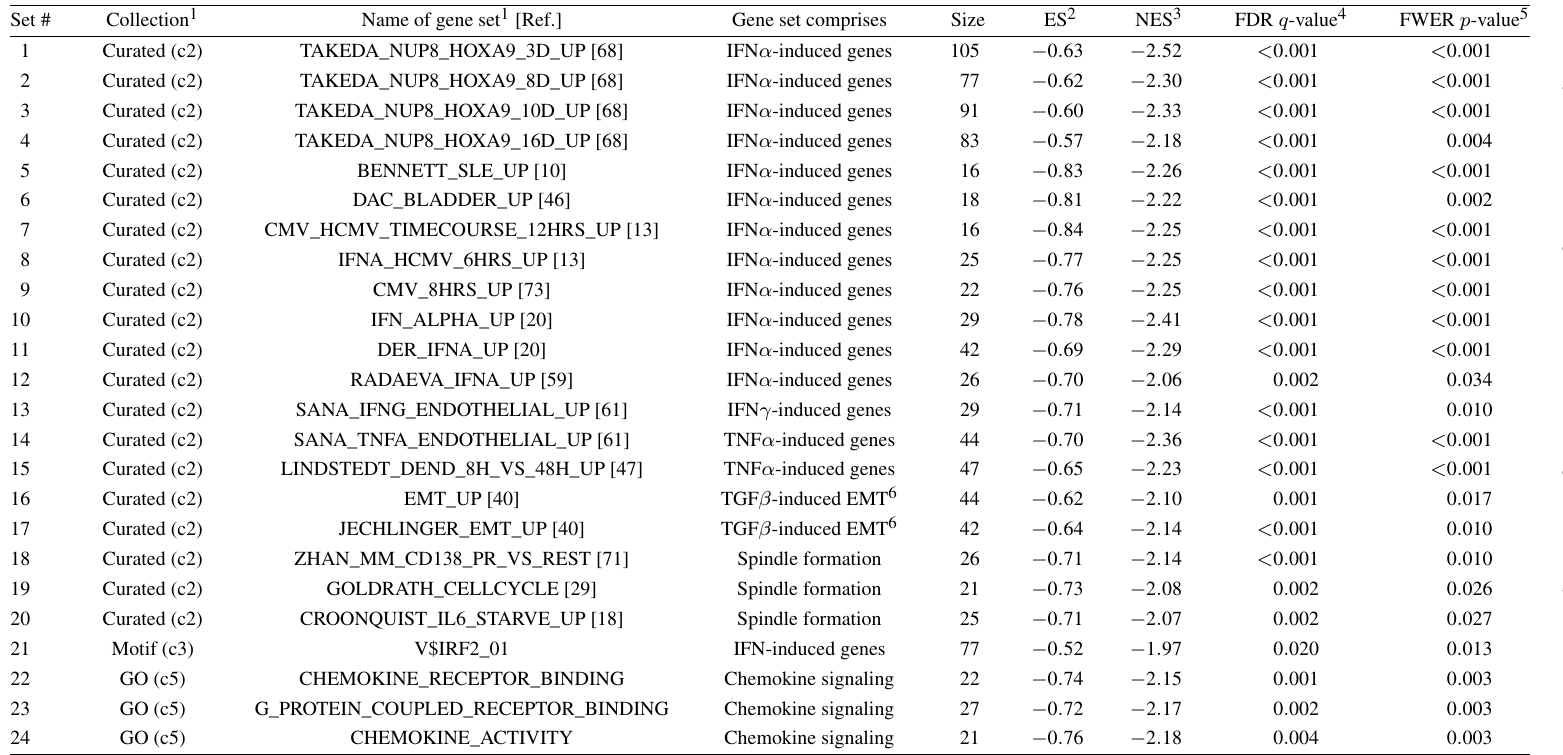
Gene sets that are more highly expressed in colon of C57BL/6J mice compared to colon of C57BL/6J-Pla2g2a-Tg